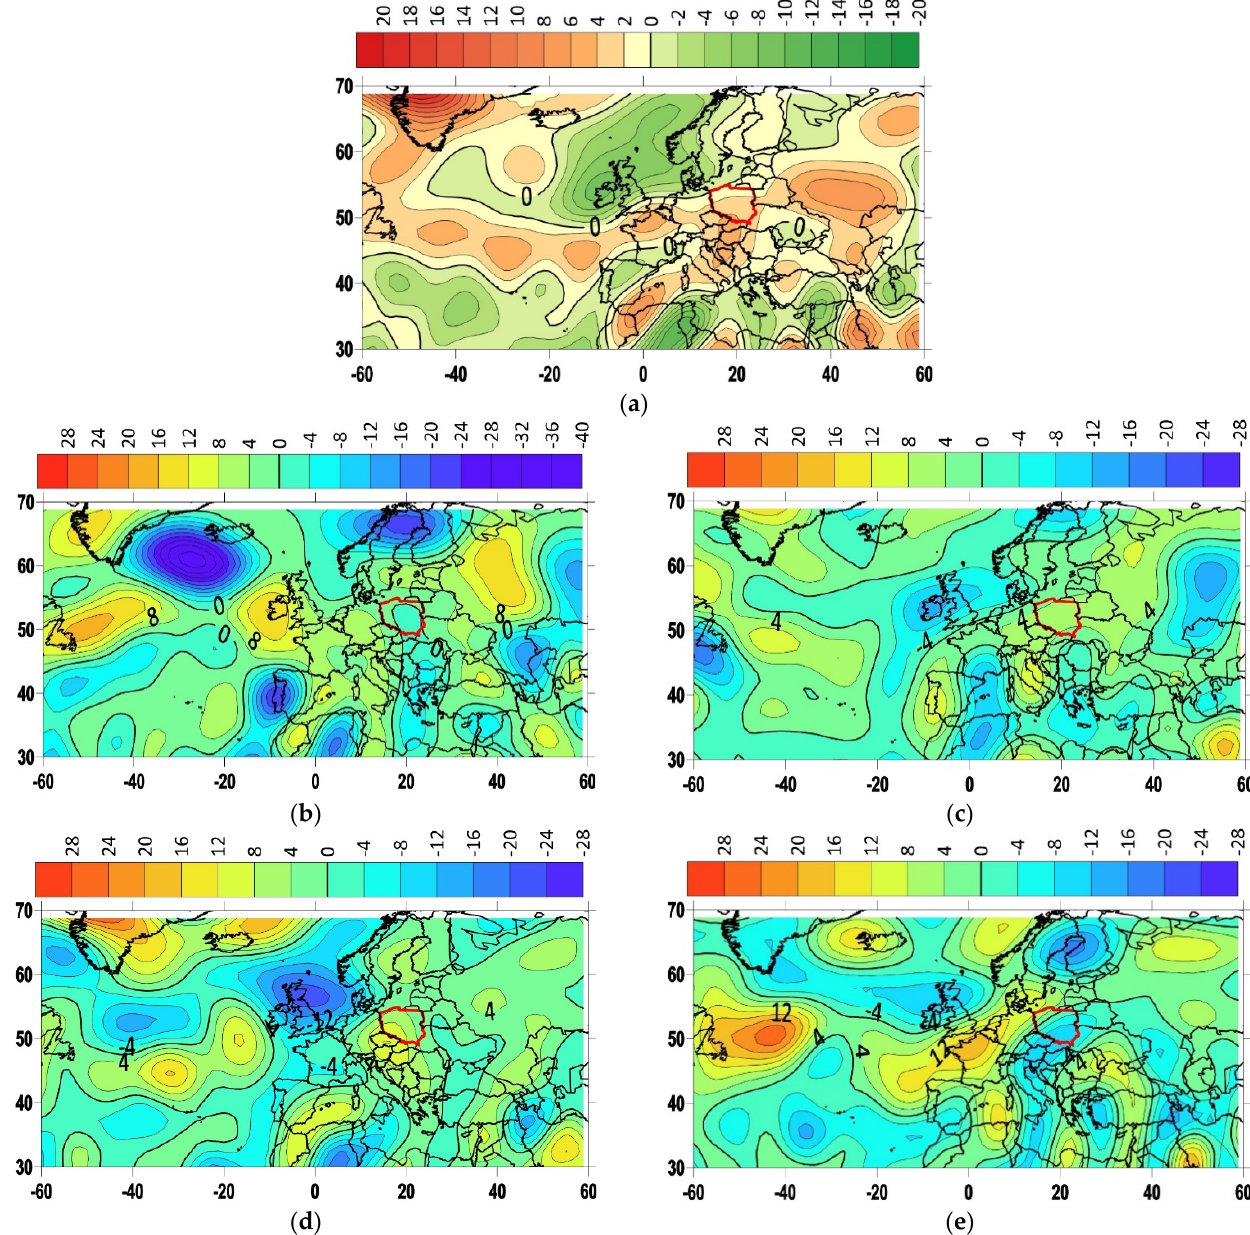
Figure 14. Vertical velocity in 10 − 2 Pa · s − 1 for 2019 heat wave: ( a ) average in the period 26.08–1.09; ( b ) on day before heat wave (25.08); ( c ) on 27.08; ( d ) on 31.08; ( e ) on day after heat wave (2.09). The red line marks the borders of Poland.